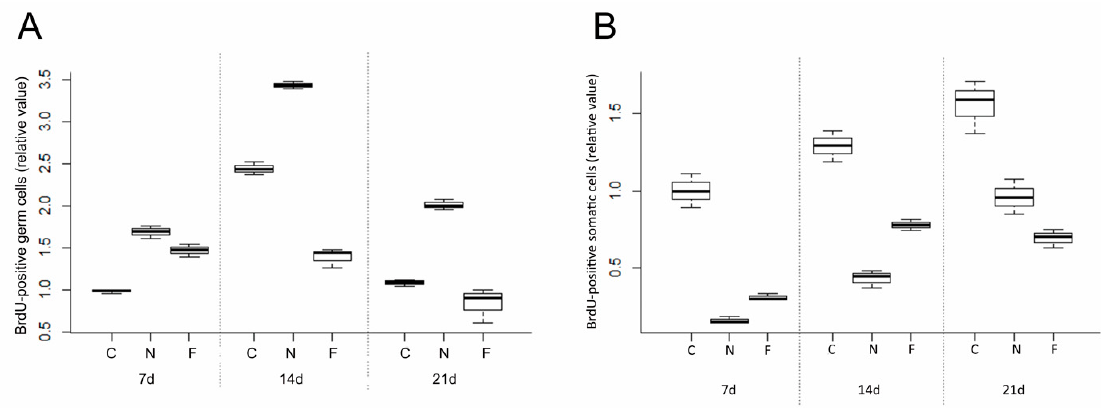
Figure 4. Effects of somatic cells on mitotic activity of Dabry’s sturgeon germ cells ( A ) and somatic